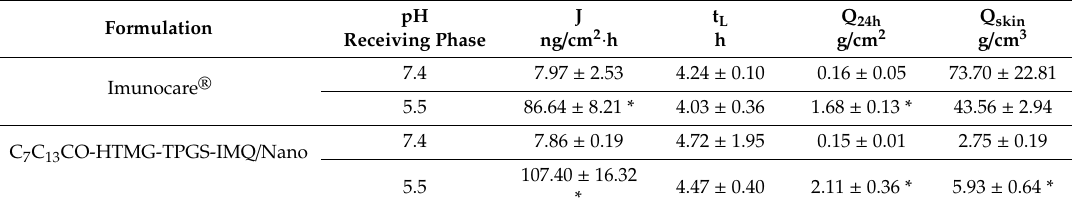
Table 5. Permeation parameters: flux (J), lag time (t L ), and amount of drug permeated through (Q 24h ) and retained into (Q skin ) the skin at the end of the experiment (24 h) from the formulations under study (mean ± standard error SE, n =